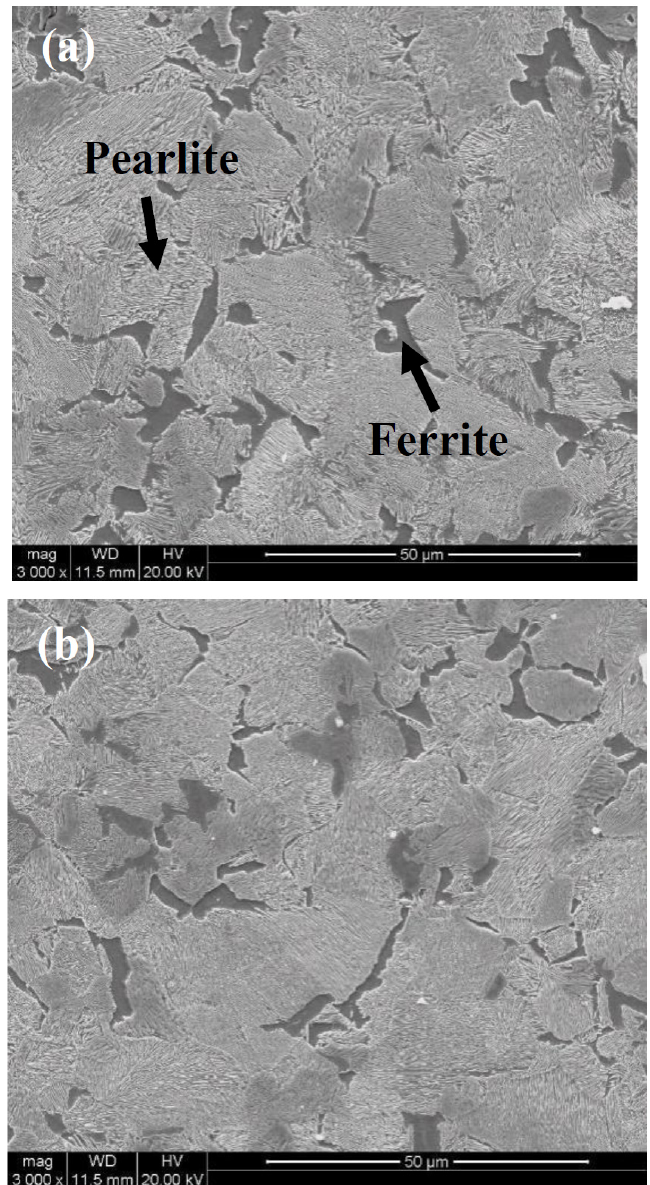
Figure 3. OM micrographs of the two tested wheel steels, ( a ) J12 and ( b ) J13.